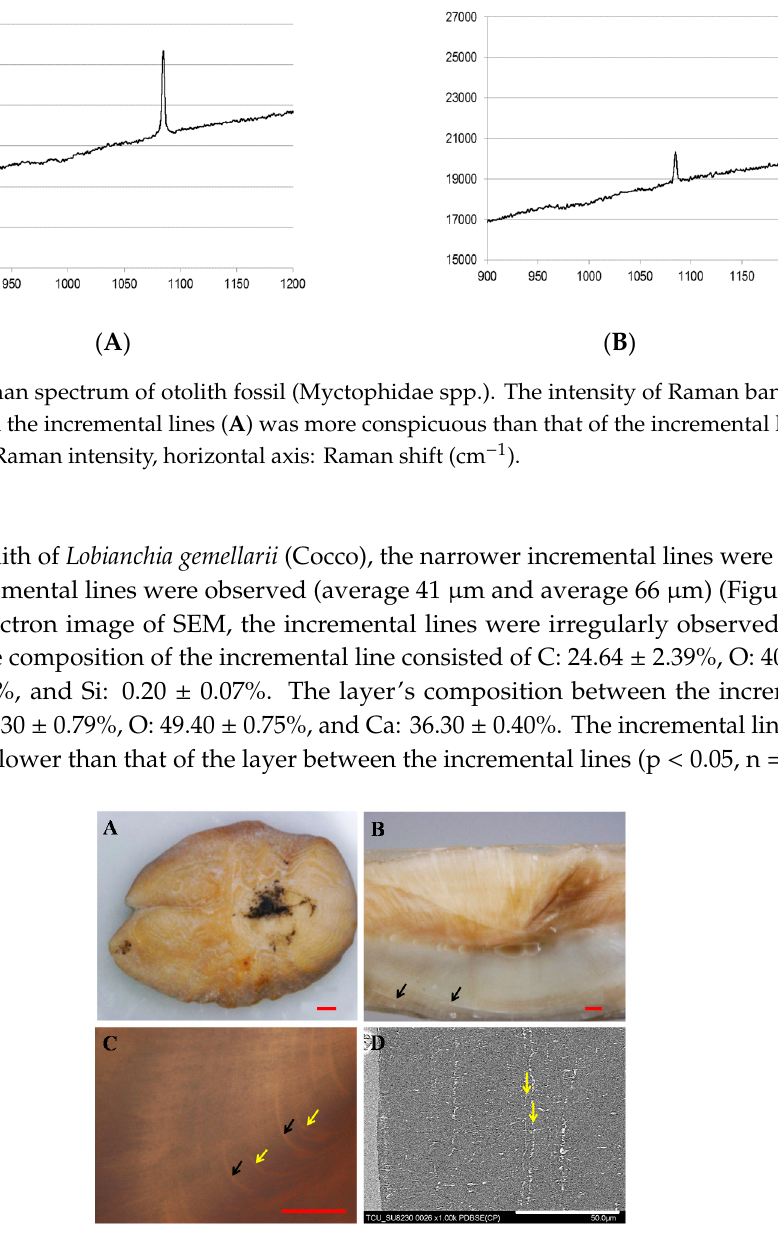
Figure 1. Raman spectrum of otolith fossil (Myctophidae spp.). The intensity of Raman band in the layer between the incremental lines ( A ) was more conspicuous than that of the incremental lines ( B ). Vertical axis: Raman intensity, horizontal axis: Raman shift (cm − 1 ).